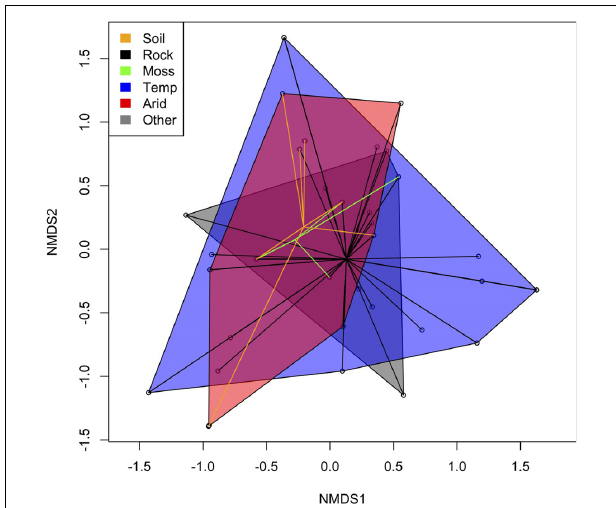
FIGURE 4 | Result from non-metric multidimensional scaling (NMDS) analysis using presence/absence data from 25 chemical substances based on high-performance thin layer chromatography (HPTLC) assays. Open dots represent studied samples. Color lines connecting dots indicate different substrates. Orange indicates specimens on soil, black on rocks, and green on mosses. Colored areas indicate geographic localities, where blue shows samples collected from temperate/Mediterranean climate region and red from arid